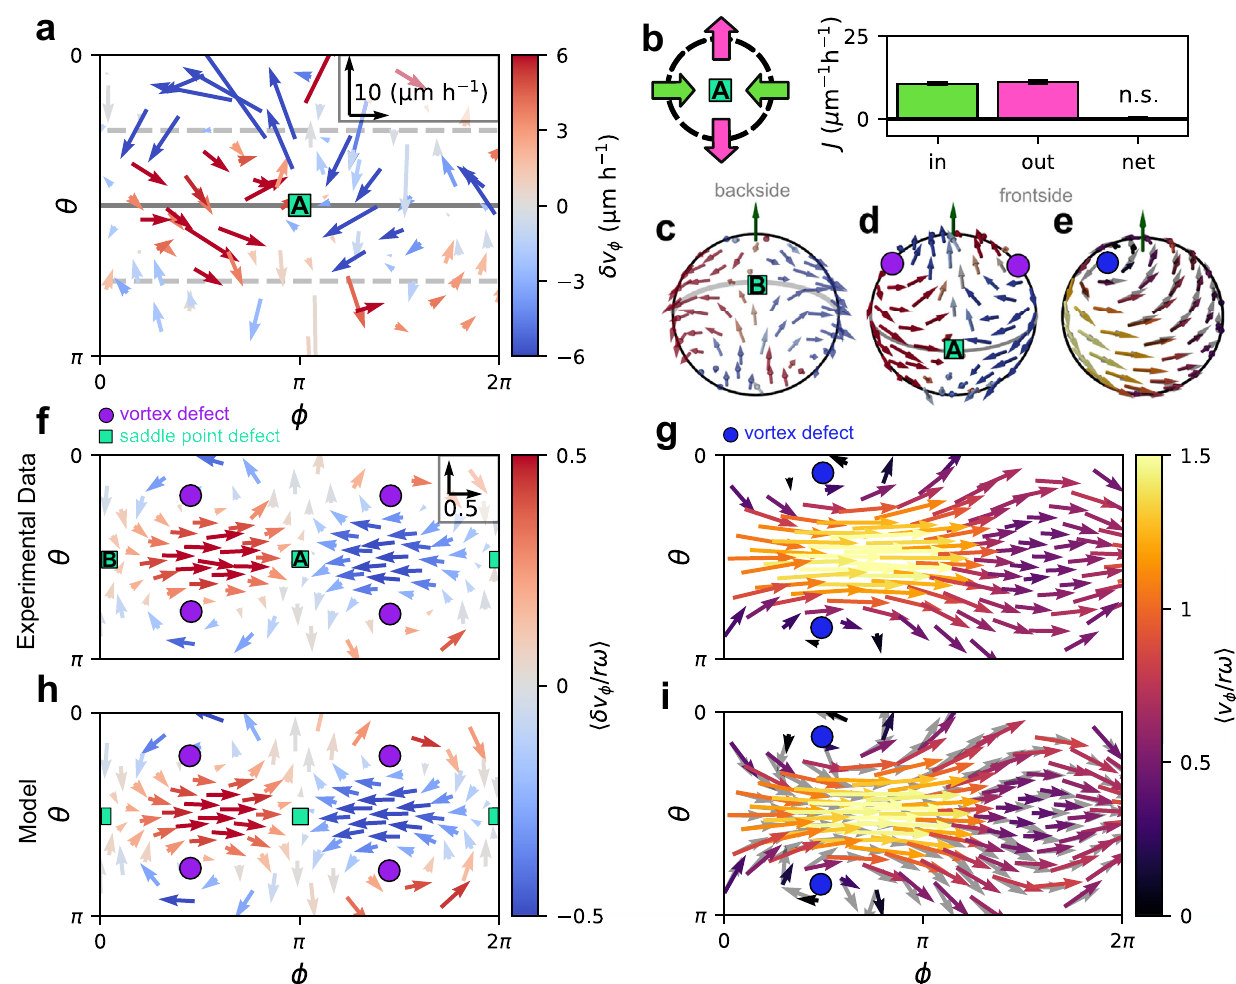
Fig. 3 | Supracellular fl ow patterns on the spheroid surface. a Snapshot of the tangential velocity fl uctuation fi eld, δ v t , in the surface layer of an individual spheroidrepresentedinsphericalcoordinates ϕ and θ (seethe “ Methods ” section). Inset: vector scale. b Flux analysis around the saddle point ahead of the velocity wave maximum (see the “ Methods ” section).Bar plot shows the absolute values of the average in fl ux (mostly along the equator) and out fl ux (mostly towards the poles). Black bar indicates the difference between in fl ux and out fl ux, which is not signi fi cantlydifferentfrom0accordingtoatwo-sided t -test( p =0 : 9). c , d Backside ( c ) and frontside ( d ) of the average velocity fl uctuation fi eld of the experimental spheroids. Both are shown from the same perspective, with the backside fi eld